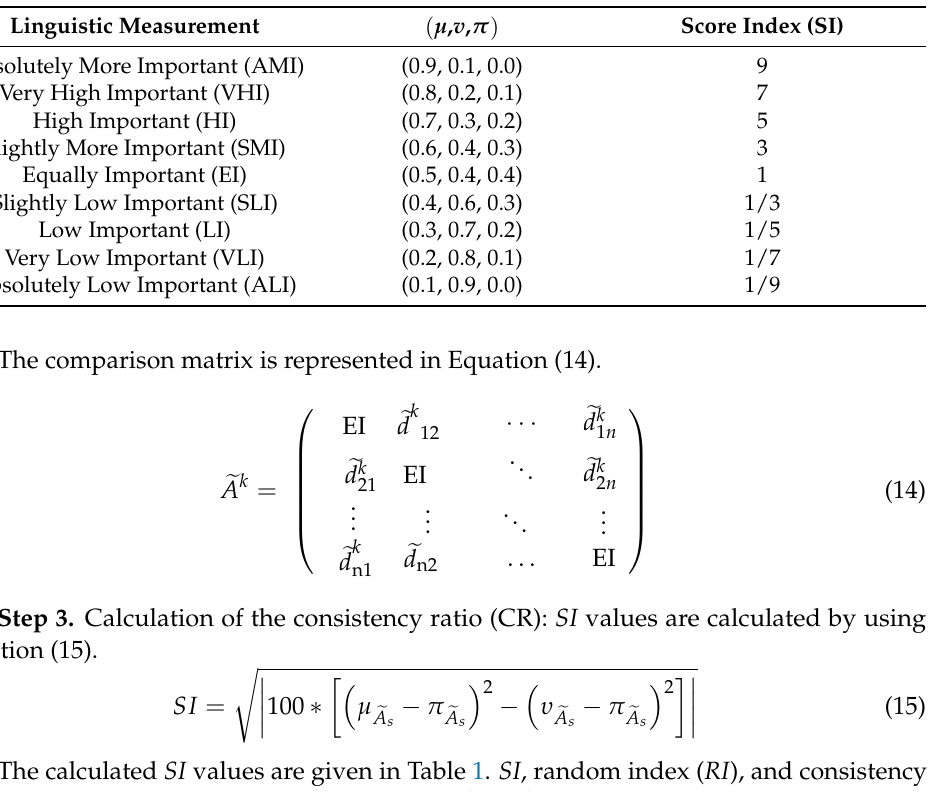
Table 1. SF-AHP preference scale for pairwise comparisons [47].